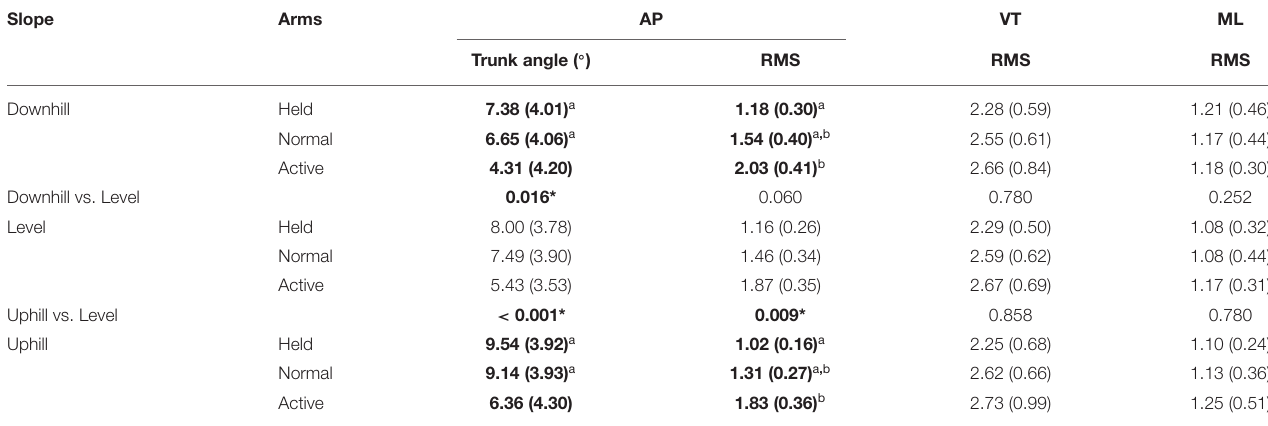
TABLE 5 | Comparison of kinematic postural variables in the three arm swing conditions during uphill, level, and downhill walking in the anteroposterior (AP), vertical (VT), and mediolateral (ML) directions; Data within each slope are represented as the mean values averaged for all 15 participants (8 male, 7 female), mean (standard deviation). Slope